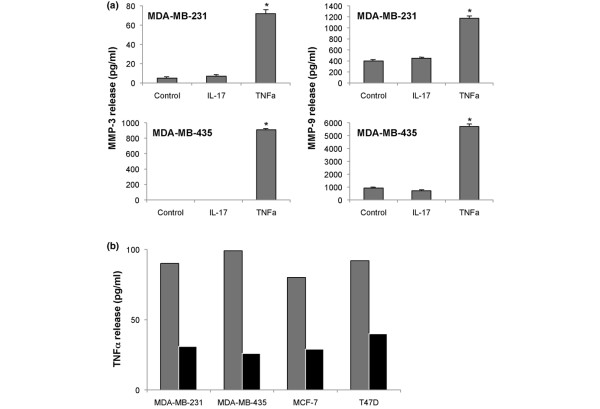
Effect of IL-17 on MMP and TNF expression. (a) IL-17 does not affect the secretion of matrix metalloproteinase (MMP)-2, MMP-3, MMP-9 or tissue inhibitor of matrix metalloproteinase (TIMP). The supernatants of control and treated (IL-17 or TNFα) tumour cell lines were assayed for the presence of MMP-2, MMP-3, MMP-9 and TIMP-1 and TIMP-2 by Luminex immunoassay or ELISA. The invasive breast cancer cell lines MDA-MB231 and MDA-MBA435 were seeded into 24-well plates (1 × 105/well) and rested overnight. Cells were treated with IL-17 (200 ng/ml) or TNFα (40 ng/ml) for 24 hours and the supernatants were harvested for assay. Results are representative of two independent assays and show the mean ± standard deviation of triplicate determinations for one of two experiments (*P < 0.01). The levels of MMP-2 were unaffected by any treatment, and the levels of TIMP inhibitors remained unchanged (data not shown). (b) IL-17 acts independently of TNFα. A panel of breast cancer cell lines were seeded into 24-well plates (1 × 105/well) and rested overnight. Cells were left untreated (grey bar) or were treated with 200 ng/ml IL-17 (black bar) for 24 hours and the supernatants were harvested for TNFα ELISA. Results are representative of two independent assays and show the mean ± standard deviation of triplicate determinations for one of two experiments (*P < 0.01). The concentration of recombinant added TNFα (expected 40 ng/ml) required to stimulate migration was actually found to correspond to 17,205 ± 1,020 pg/ml in this assay.